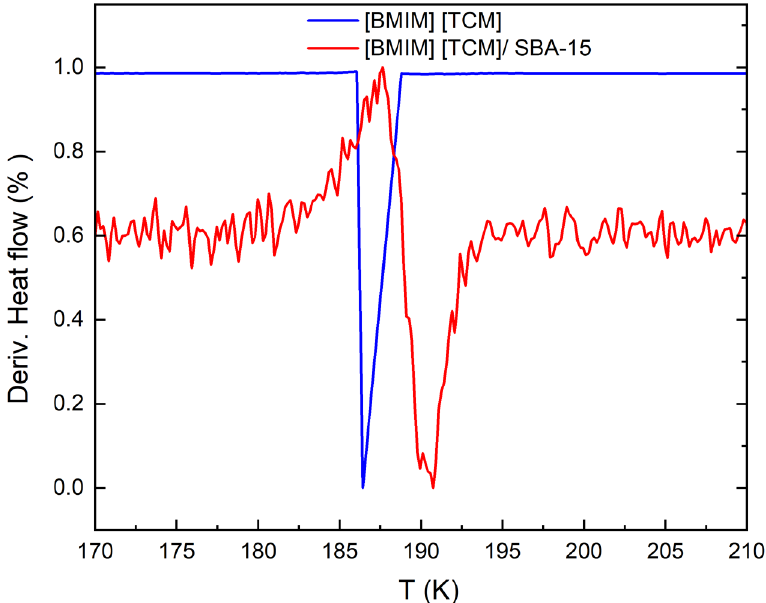
Figure A1. Results of the derivatives of the heat flow in the relevant Differential Scanning Calorimetry (DSC) experiments. As observed, there is a difference of approximately 4.1 K between the two glass transition temperatures ( Tg for the bulk IL is 186.4 K and Tg for the confined IL inside SBA-15 is 190.5